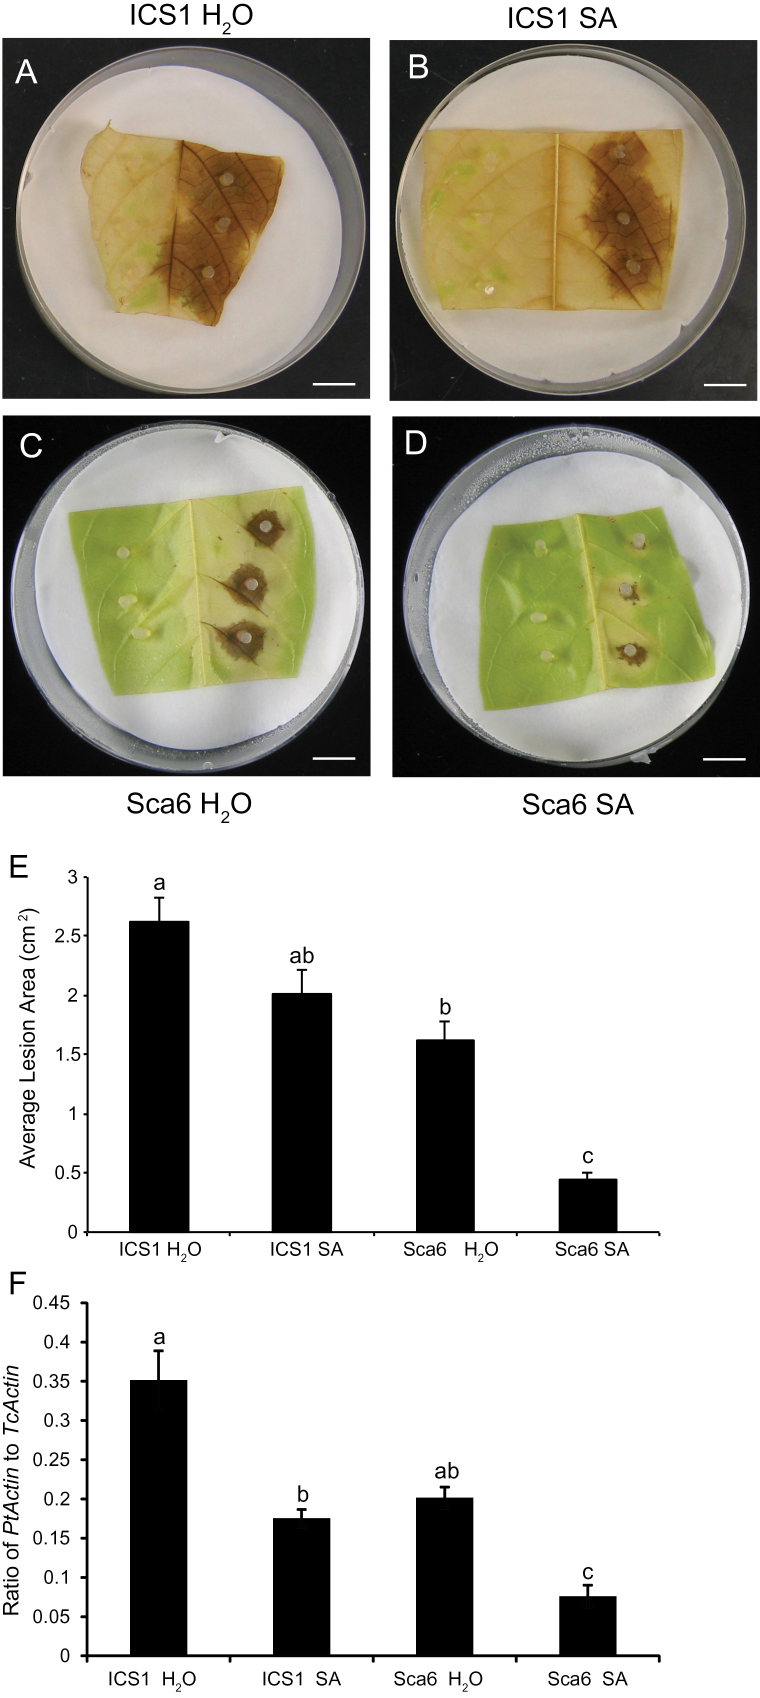
Inoculation of SA pre-treated stage C leaves from ICS1 and SCA6 with Phytophthora tropicalis. Stage C leaves were inoculated with agar plugs containing P. tropicalis mycelium 24h after water or 1mM SA treatment. Representative images of (A) water-treated ICS1 leaves, (B) SA-treated ICS1 leaves, (C) water-treated SCA6 leaves and (D) SA-treated SCA6 leaves 3 d after inoculation. Scale bars, 1cm. (E) Average lesion areas in replicate leaves were evaluated by ImageJ. Data represent means ±SE of treated leaves from 24 replicates per genotype. Letters above bar chart show the significant differences (P<0.05) determined by Fisher’s PLSD analysis. (F) Relative pathogen biomass was measured by qPCR with DNA isolated 48h after inoculation and is expressed as the ratio of P. tropicalis actin to cacao actin. Bars represent means ±SE of four biological replicates, each with three technical replicates. Letters above the bar show the significant differences (P<0.05) determined by Fisher’s PLSD analysis.